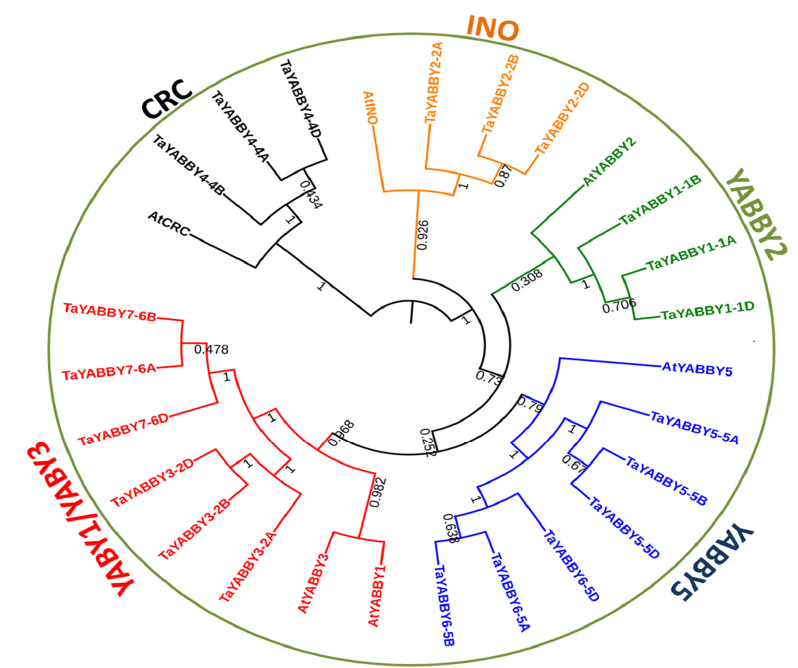
Figure 1. Phylogenetic tree of the YABBY genes between Arabidopsis and wheat based on characterized YABBY genes in Arabidopsis. Bootstrap values were calculated in 1000 replications by using MEGA 7.